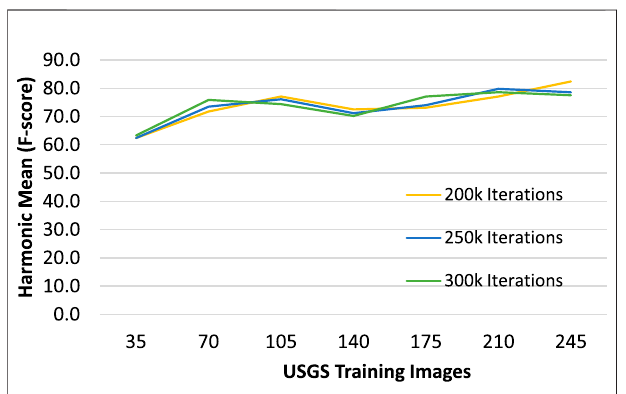
FIGURE8| Testaccuracyby35-imagebatchesusing200 k,250 k,and 300 k training